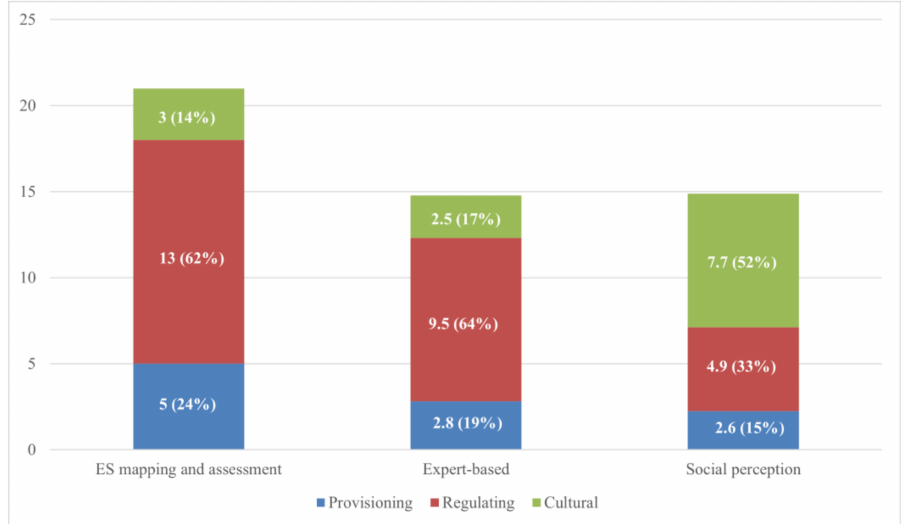
Figure 8. Aggregated values assigned to each ES category (provisioning, regulating and cultural) by the three evaluation methodologies considered in the